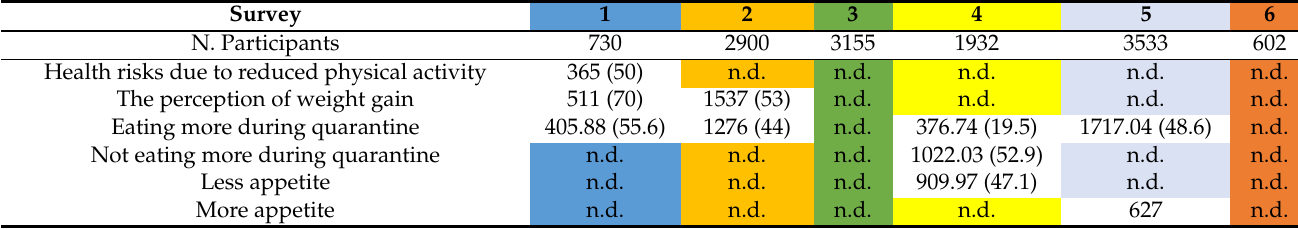
Table 9. Changes in activities and in eating habits, absolute value (N.) and (%) on the total. Survey